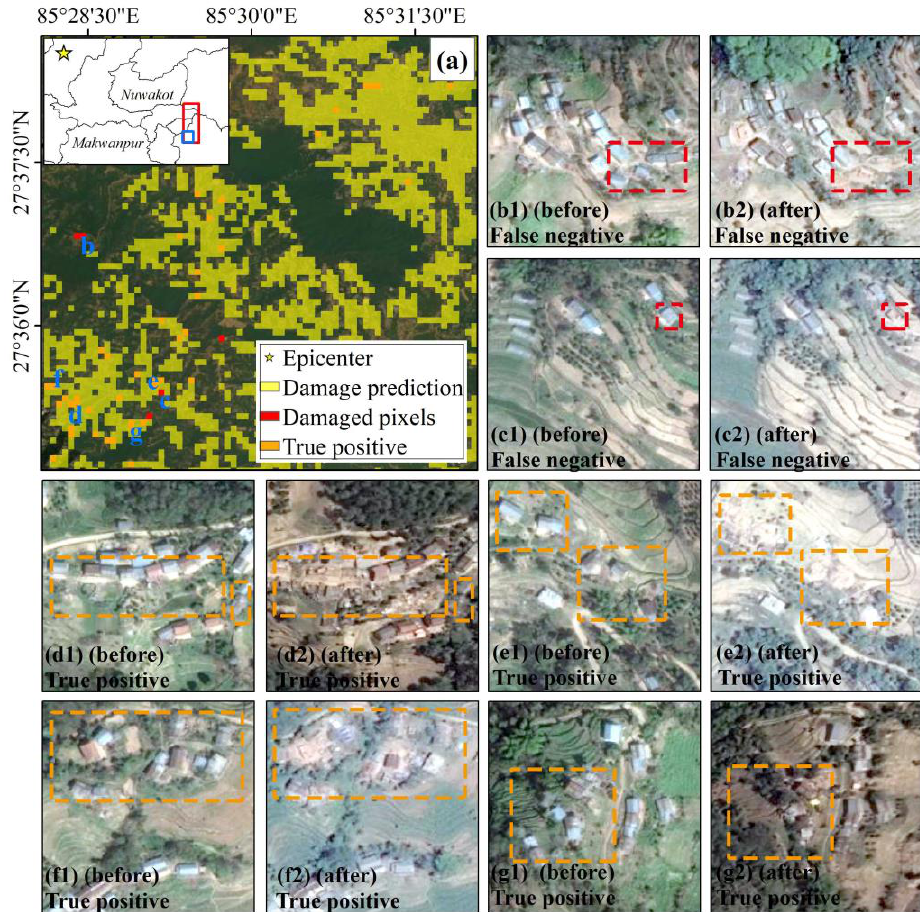
Figure 13. Validation of classified results of damaged pixels on remote sensing images. Remote sensing validation data were produced by UNOSAT project of UNITAR. The selected verification pixels are distributed in the blue box of the thumbnail (part of the test area). In subplot ( a ), the yellow pixels represent the classified damaged pixels, the red pixels represent the damaged locations interpreted from optical image, and the orange pixels represent the correctly classified damaged pixels (true positive). The sampling pixels b to g are marked in subplot ( a ) in blue font. Subplots ( b1 , c1 ) and ( b2 , c2 ) are optical images at the positions of red pixels (false negative) before and after earthquake, respectively. Subplots ( d1 – g1 ) and ( d2 – g2 ) are optical images at the positions of orange pixels (true positive) before and after earthquake, respectively. The red and orange dash boxes indicate the locations of the damaged buildings.